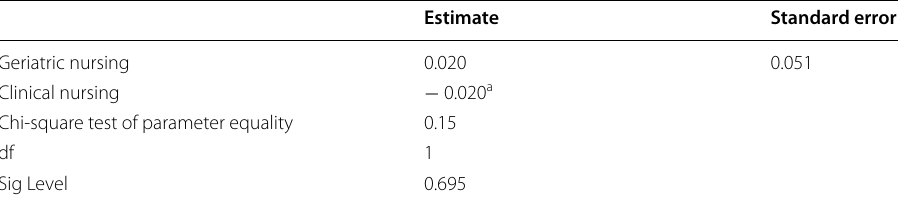
Table 18 Global DIF analysis to identify subgroup invariance between specializations for measurement in the third year